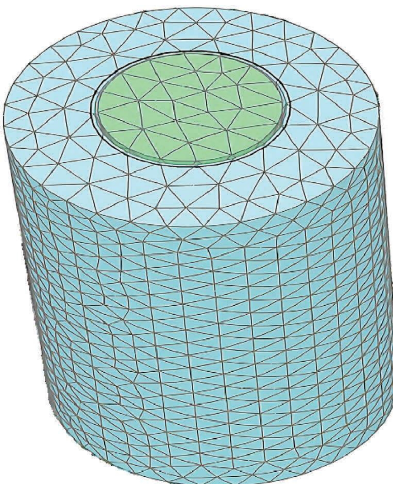
Figure 2: Generated mesh of the model with ordinary stone column (OSC).